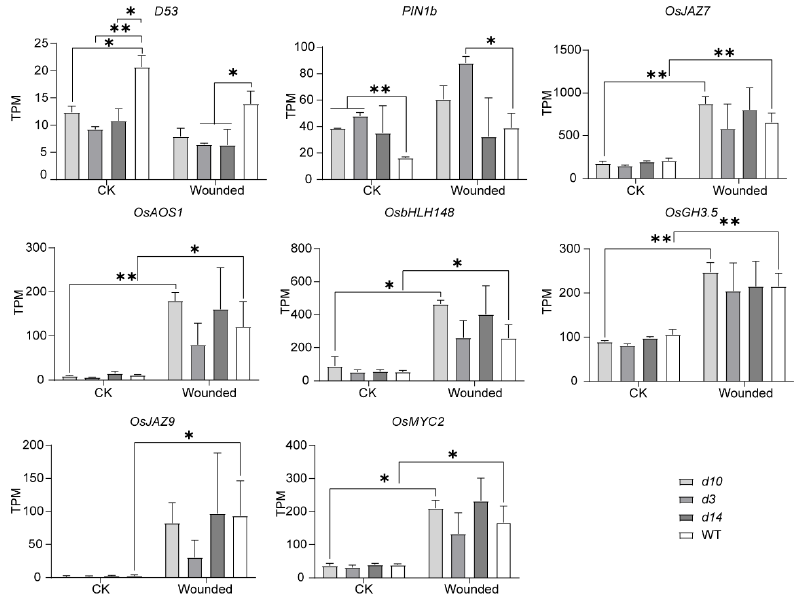
Figure 3. The transcripts per million (TPM) of SLs and JAs pathway-related genes in SLs mutants and wild-type plants before and after wounding. The data were represented as mean ± SD of two biological replicates. The Student’s t -test analysis indicated a significant difference (* p < 0.05, ** p < 0.01).